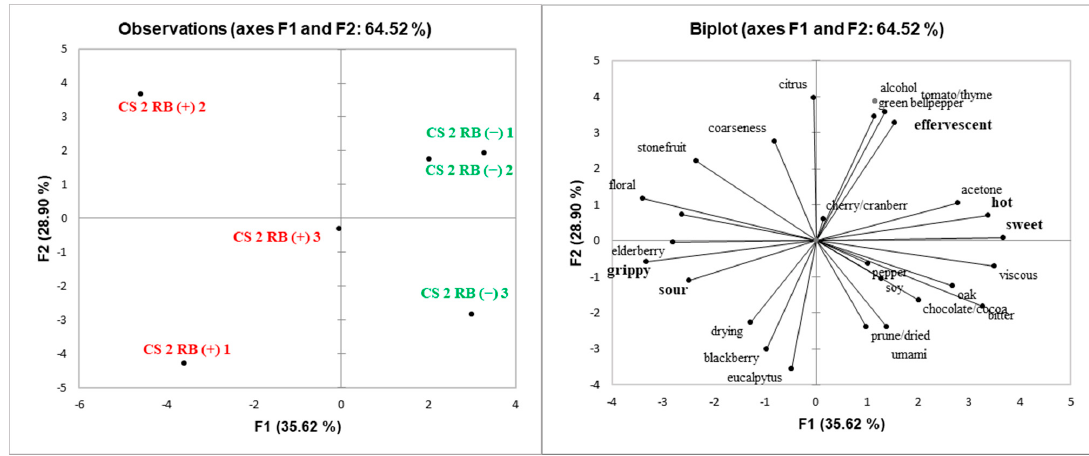
Figure 5. Score (left) and loadings (right) plots of principal component analysis (PCA) of CS2 RB ( − ) and RB (+) 2015 wines. Attributes found to be significantly different by ANOVA ( p < 0.05) are in